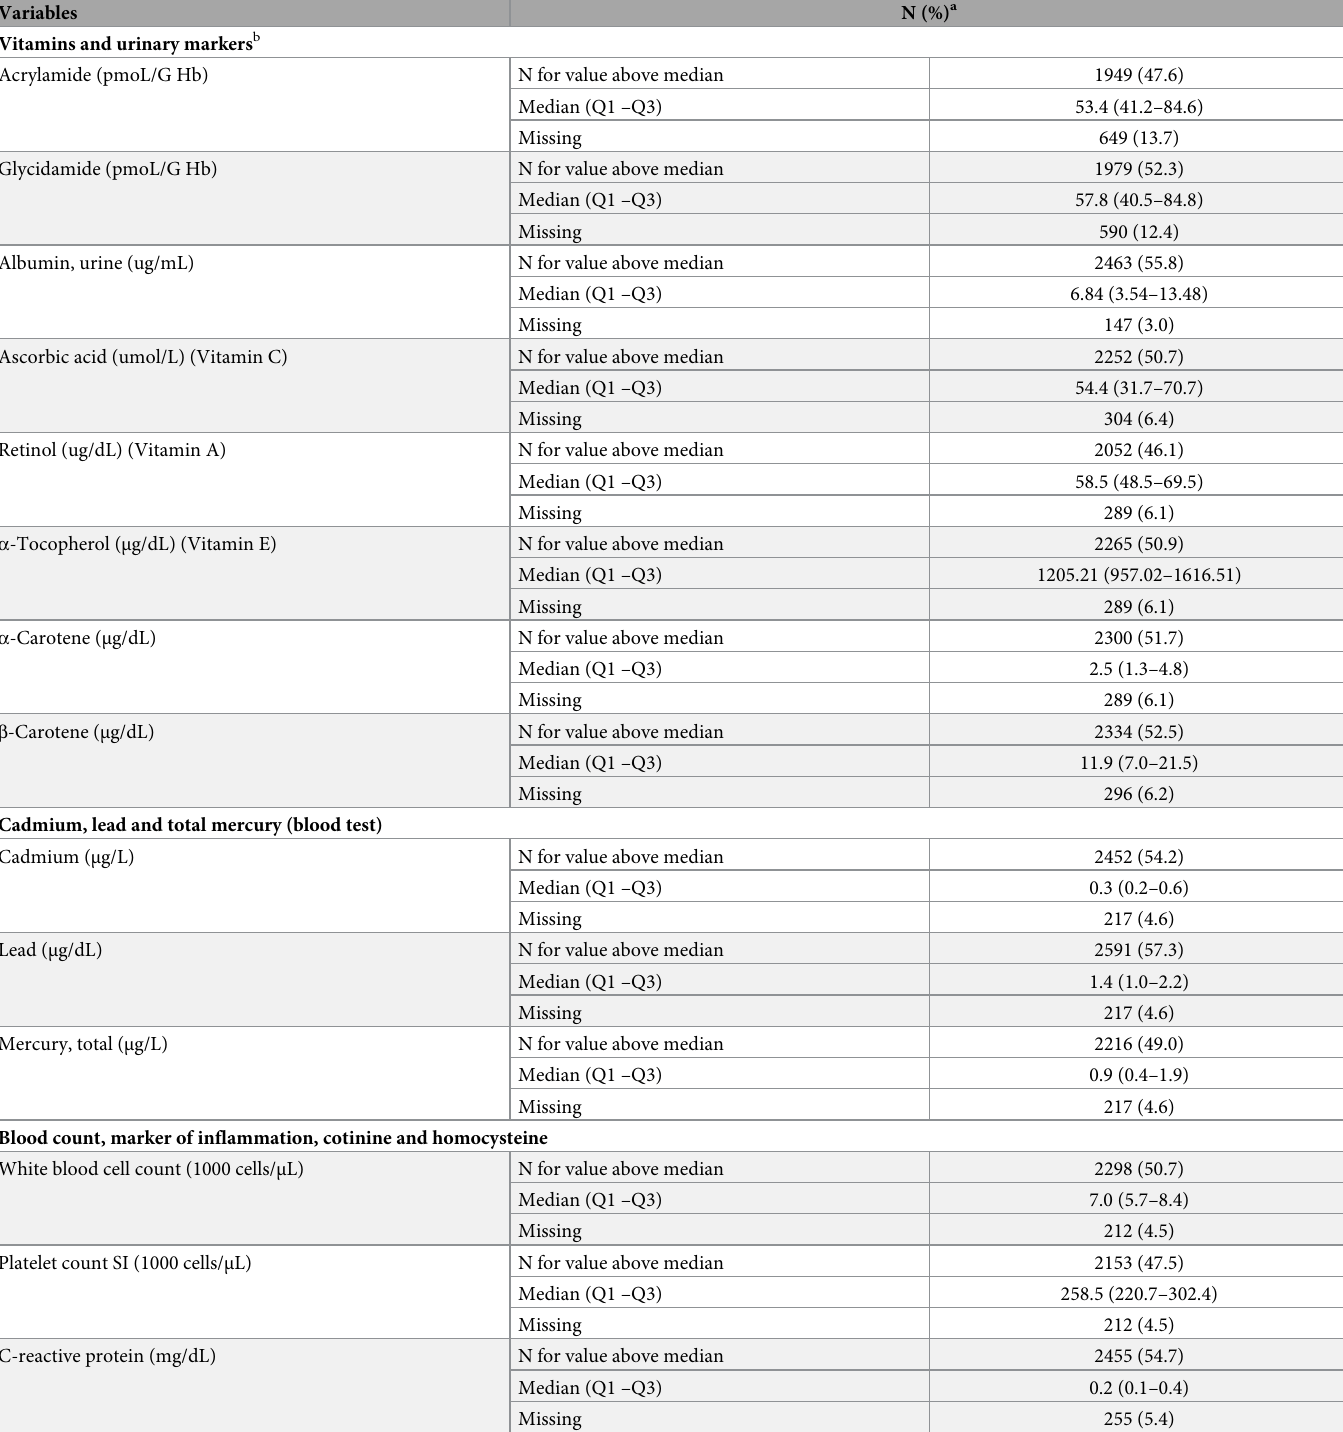
Table 2. Specific biomarkers considered in main analyses (n =